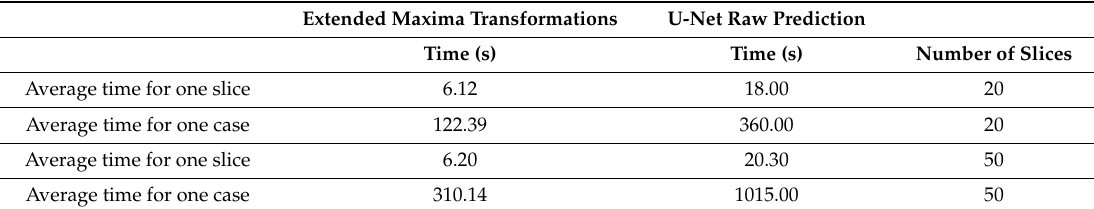
Table 4. Detailed test results of performance tests. We compared average time for one slice and for one case (20 and 50